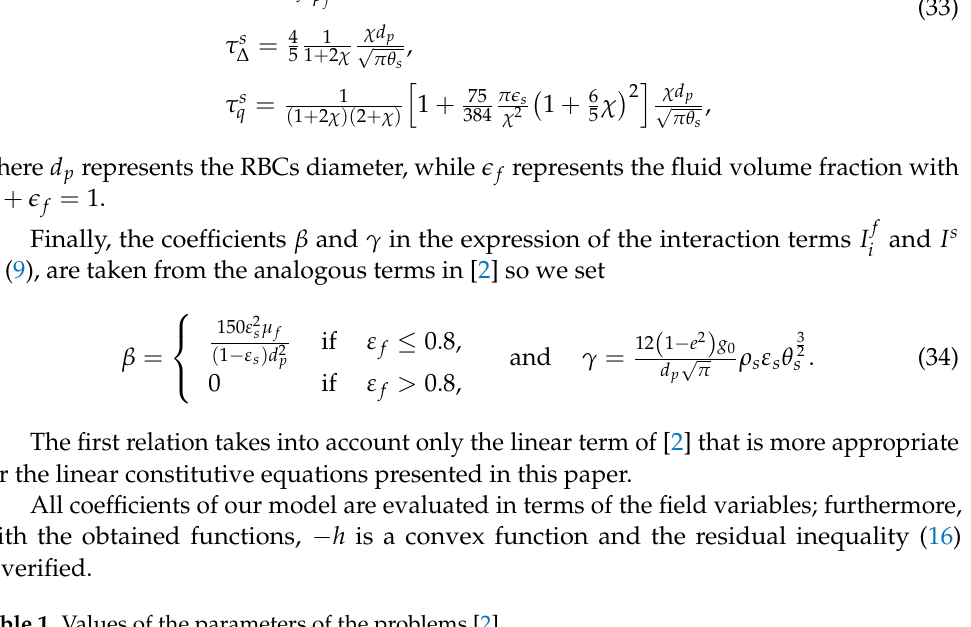
Table 1. Values of the parameters of the problems